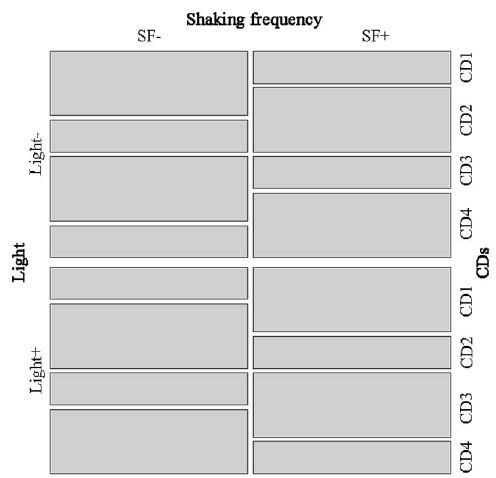
Figure 1. Mosaic plot for three selected factors (light, shaking frequency (SF) and cyclodextrins (CD1-no cyclodextrin; CD2- b - cyclodextrin; CD3-methyl- b -cyclodextrin and CD4-triacetyl- b - cyclodextrin)) showing that any level combination of factors CDs and SF does not determine completely the level of factor ‘‘light’’ which is indicative for limited